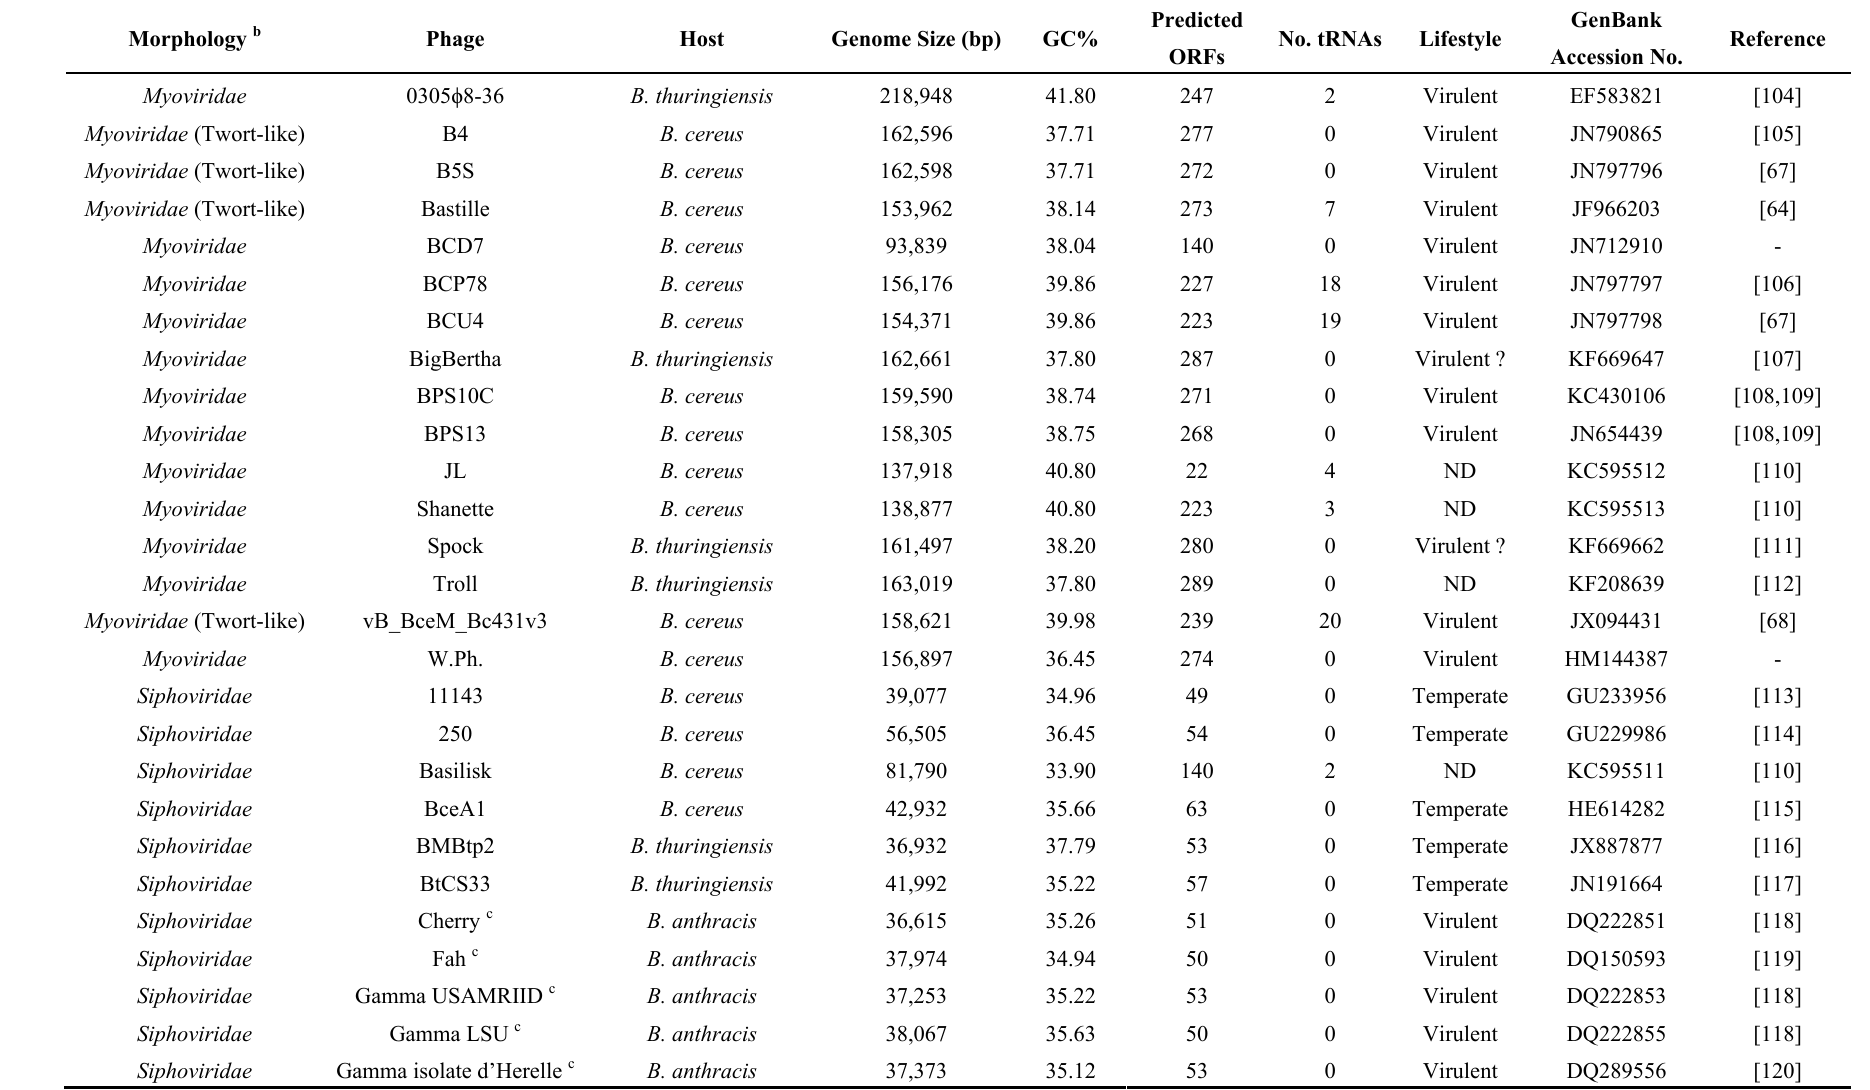
Table 4. Genomic features of fully-sequenced B. cereus group phages a